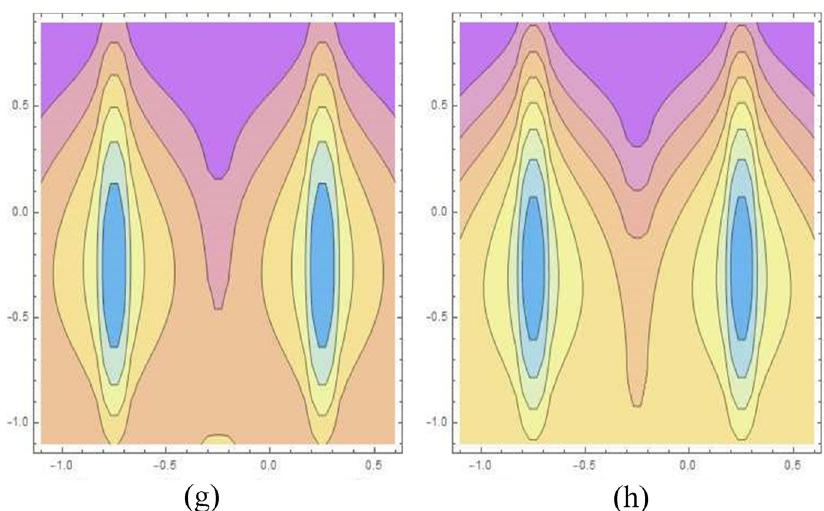
( Figure 10 ( a ) and ( b )) . The Grashof number Gr enhances θ due to gravitational agitation as seen from drawn results in Figures 11 and 12 ( a ) and ( b ) . Nanomaterial coef - fi cients ϕ and A cause temperature enhancement as 1 1 shown in Figure 13 ( a ) and ( b ) . The heat transfer Biot produces heat near the channel walls; also, number B 1 it enhances the thermal conductivity of fl uid, and so the temperature rises in all forms of considered waves ( Figure 14 ( a ) and ( b ))